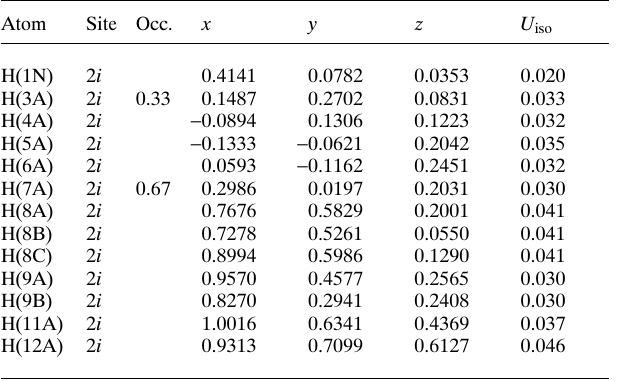
Table 2. Atomic coordinates and displacement parameters (in Å 2 )